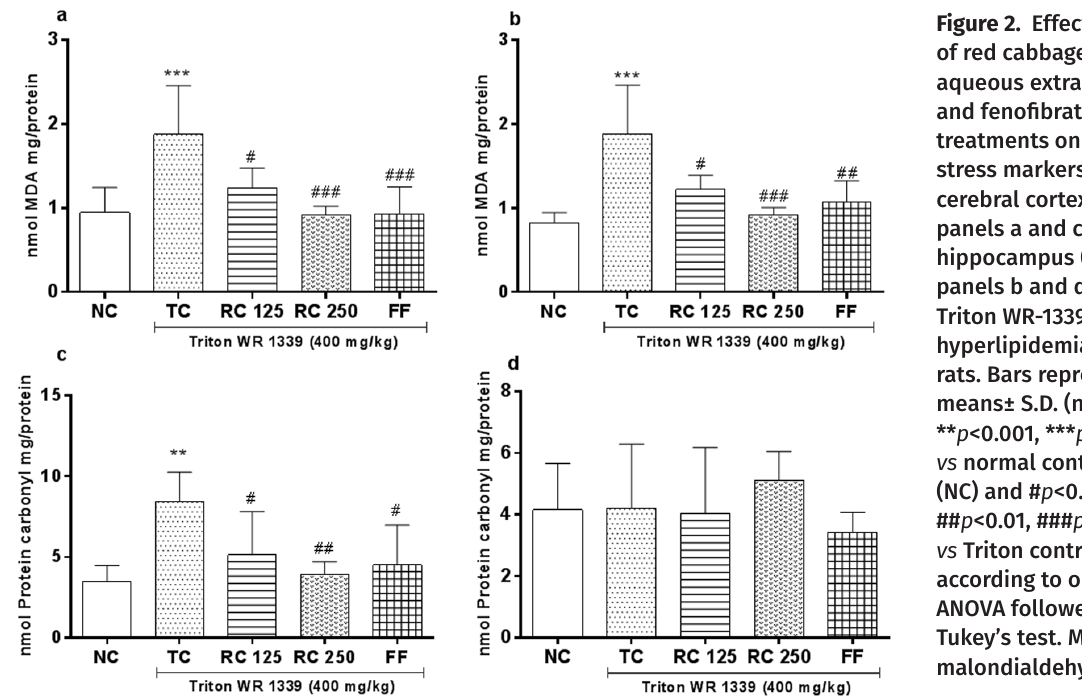
Figure 2. Effects of red cabbage aqueous extract (RC) and fenofibrate (FF) treatments on oxidative stress markers in cerebral cortex (left, panels a and c) and hippocampus (right, panels b and d) of Triton WR-1339-induced hyperlipidemia in rats. Bars represent means± S.D.